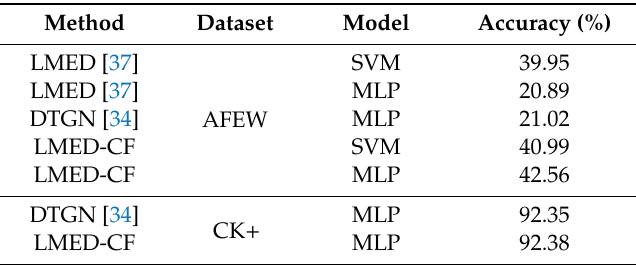
Table 9. Comparison with landmark-based